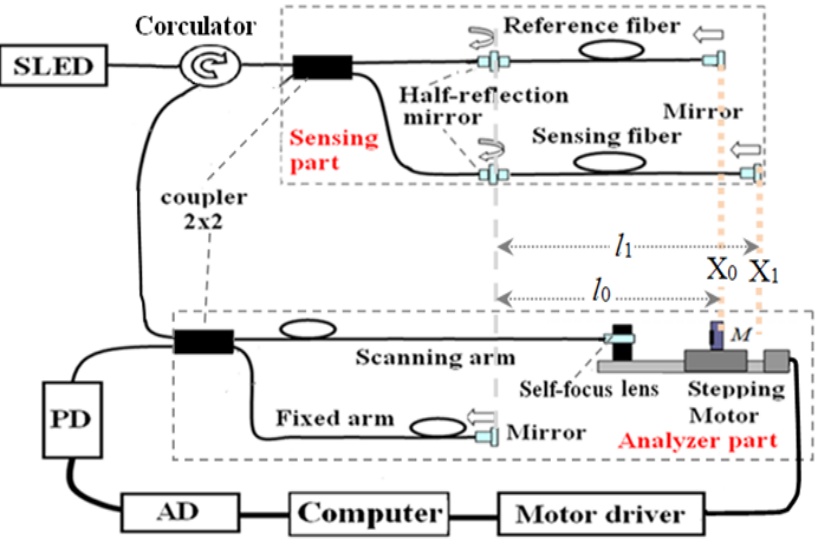
Figure 1. Configuration of the LCFS